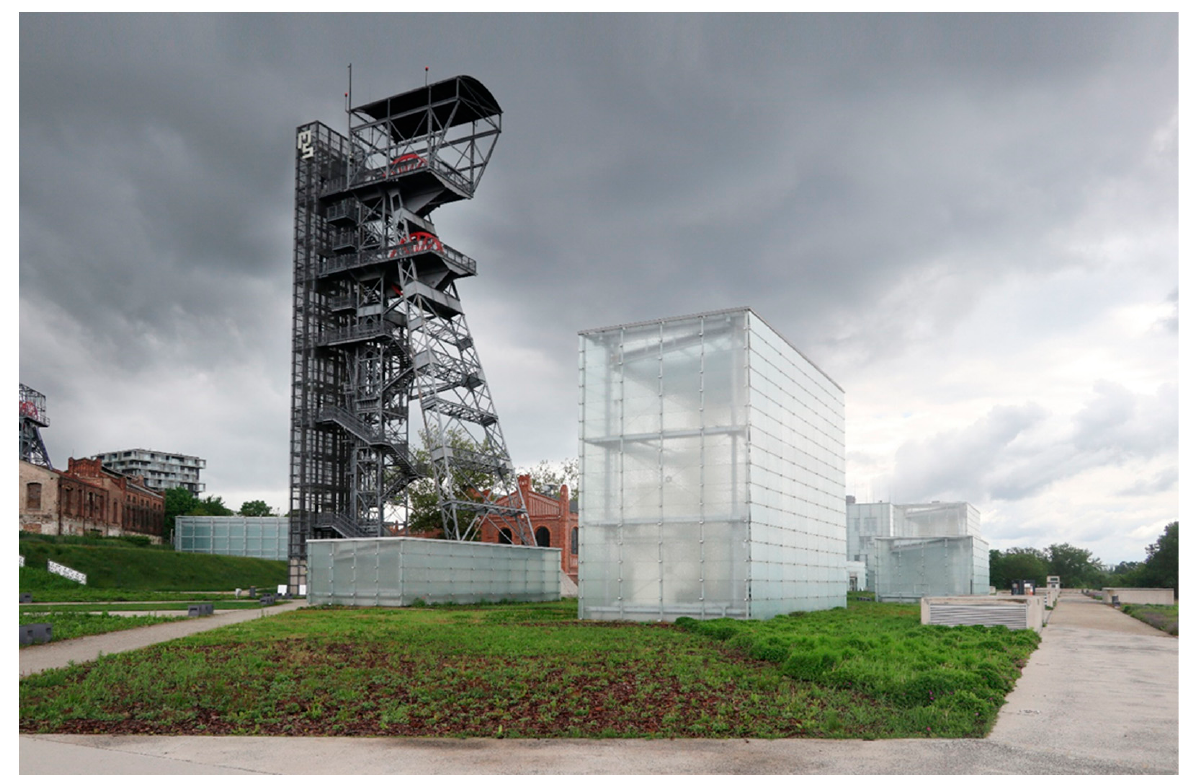
Figure 7. The Silesian Museum in Katowice, photo by Micha ł Pieczka.